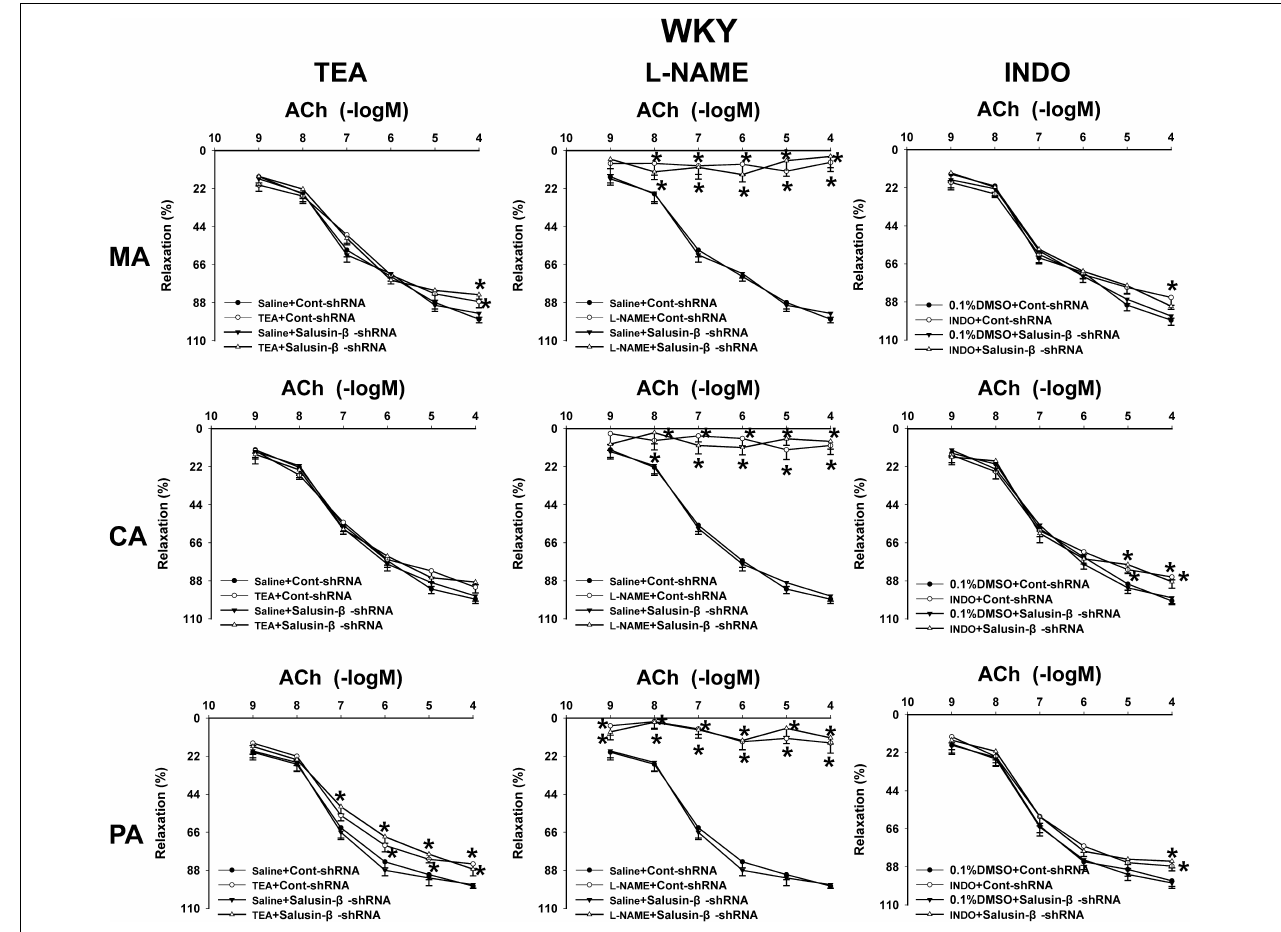
FIGURE 4 | The effects of L-NAME, INDO, and TEA on the ACh-induced vascular relaxation in MA, CA, and PA in WKY treated with Cont-shRNA or salusin- β -shRNA. One-way ANOVA was used for data analysis, followed by Bonferrioni post hoc test to compare with the multiple groups. Values are mean ± SE. ∗ P < 0.05 compared with Saline or 0.1% DMSO. n = 6 for each